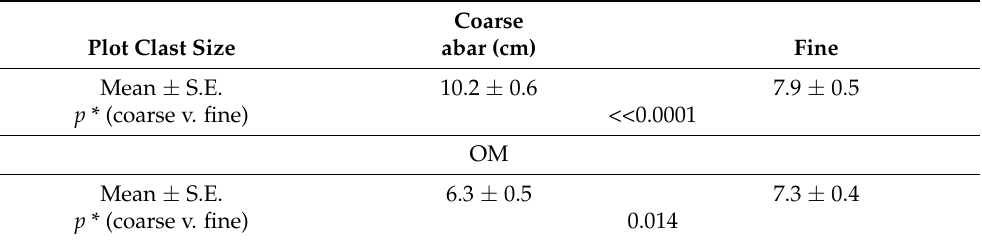
Table 4. Summary of results of Validation Test #2: differences in abar and OM between plots with relatively coarse and relatively fine clasts. Only sites where two plots at the same beach were sampled were included in analyses.